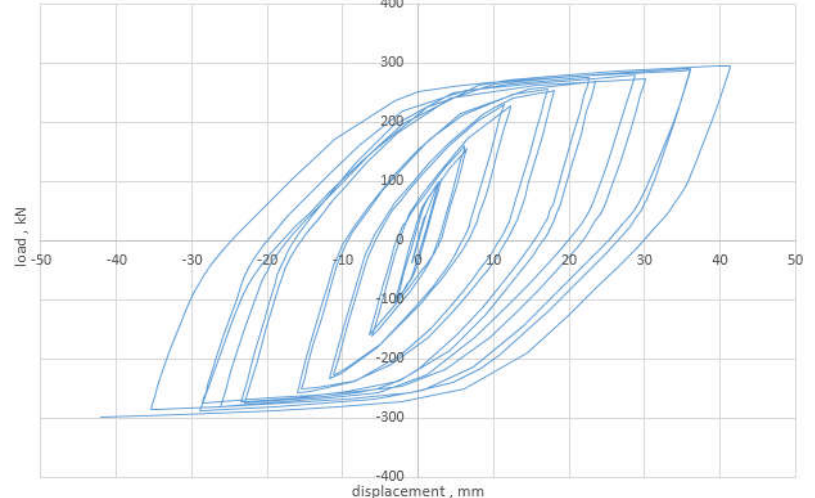
Figure 19. The hysteresis diagram due to loading on the frame.